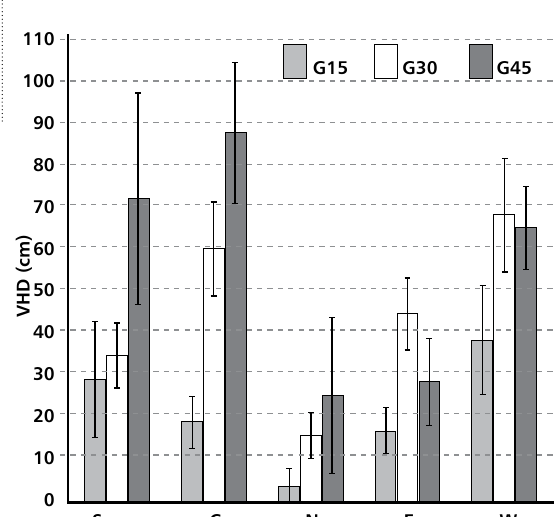
of the gaps, regardless the size of the gaps (Figure 7, Table 6). This result proves that the phenomenon that spread of blackberry was the fastest in G45